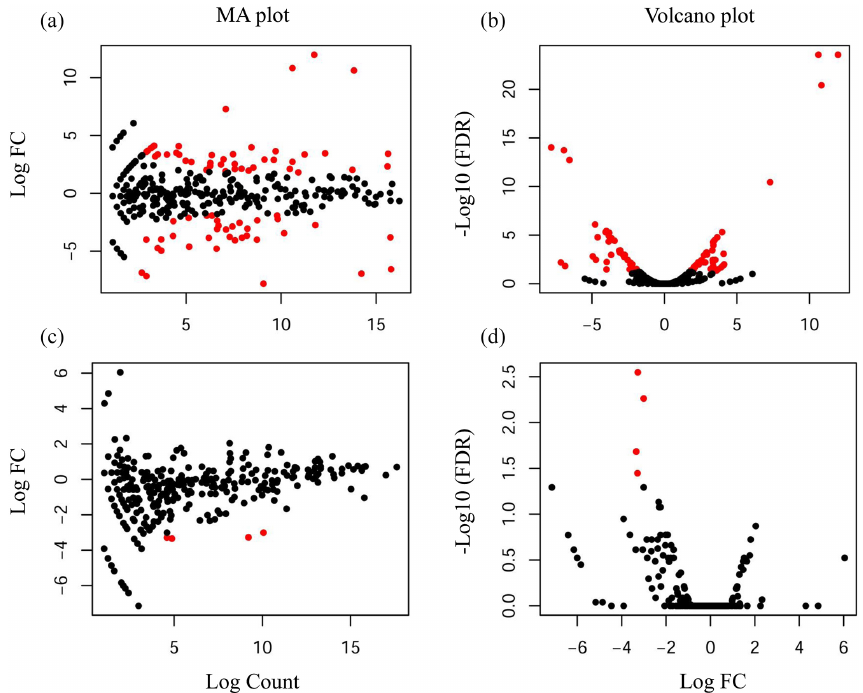
Figure 3. Differentially expressed known miRNAs were identified by deep sequencing. A MA plot (a, c) and a volcano plot (b, d) were used to display the differentially expressed miRNA patterns in UF vs. US libraries. One point as one miRNA, red points in the plot represent differentially expressed miRNAs, and black points show no statistically significant differences in the expression of miRNAs between UF and US libraries.